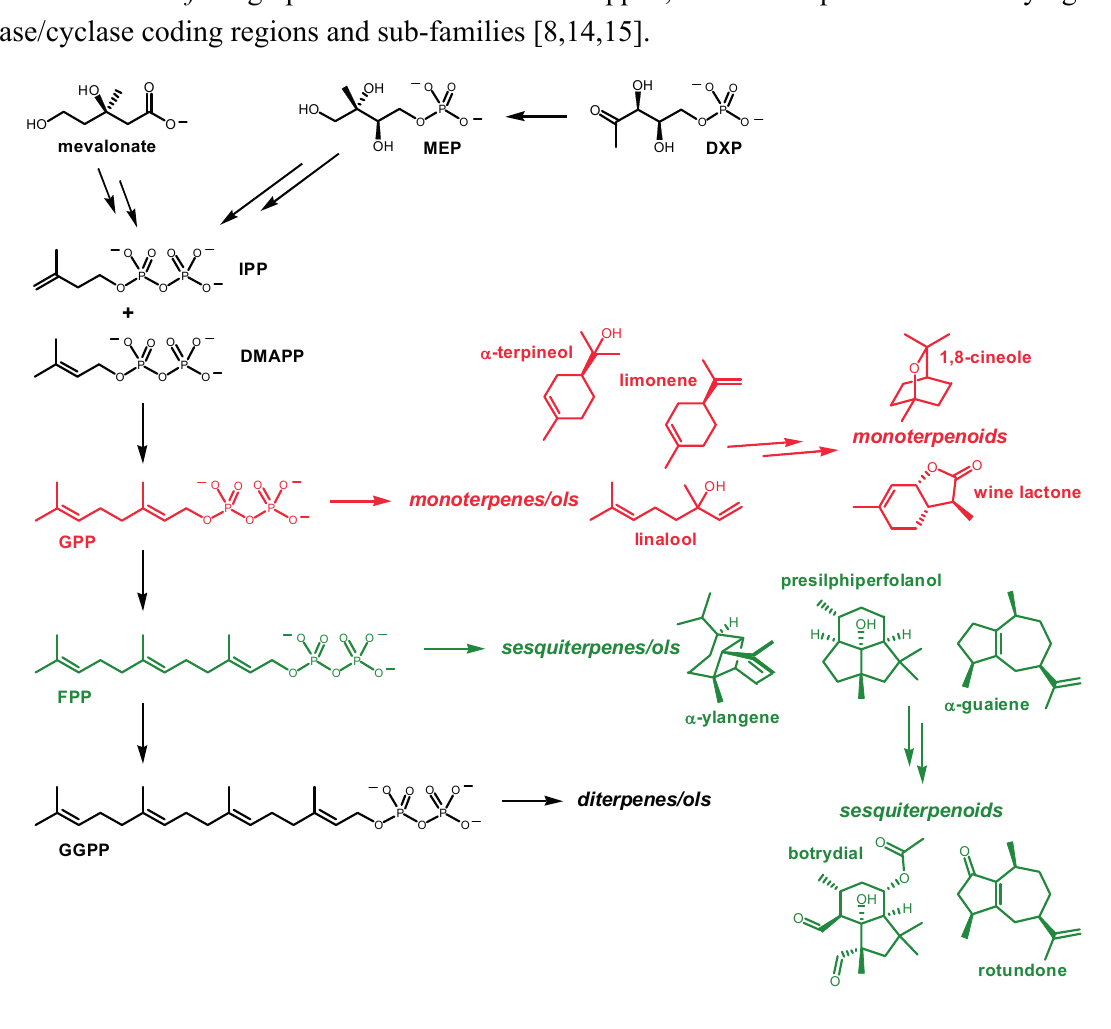
Figure 1. Overview of chemical transformations in terpene